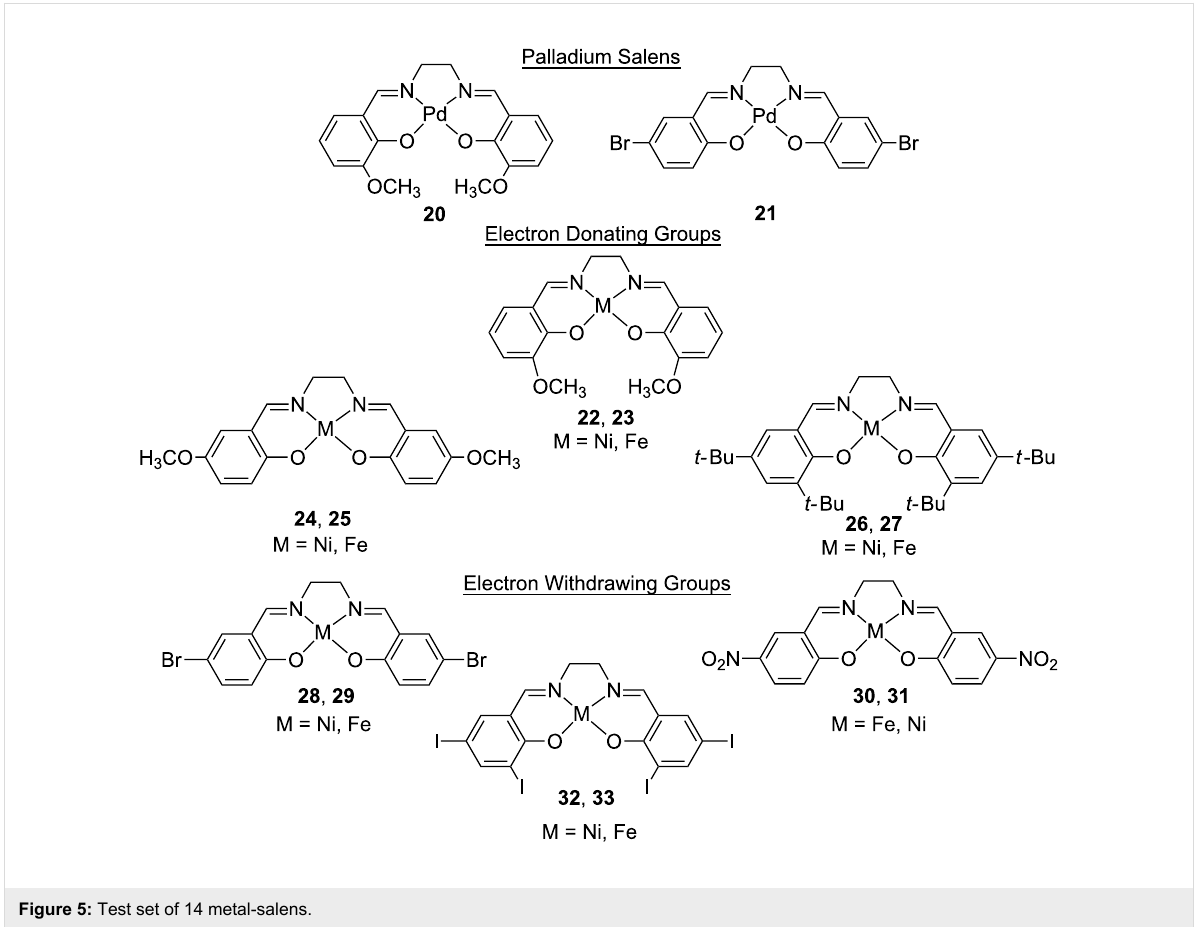
Figure 5: Test set of 14